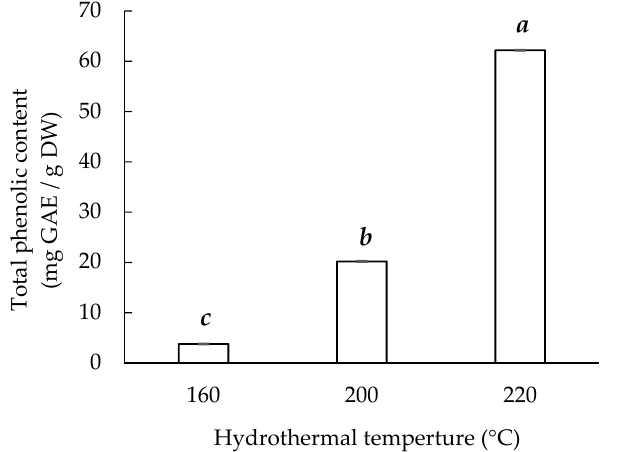
Figure 2. Hydrothermal extraction temperature and total phenolic content of sericin extracts. Means with the same lowercase letters are not significantly different, per LSD test results.